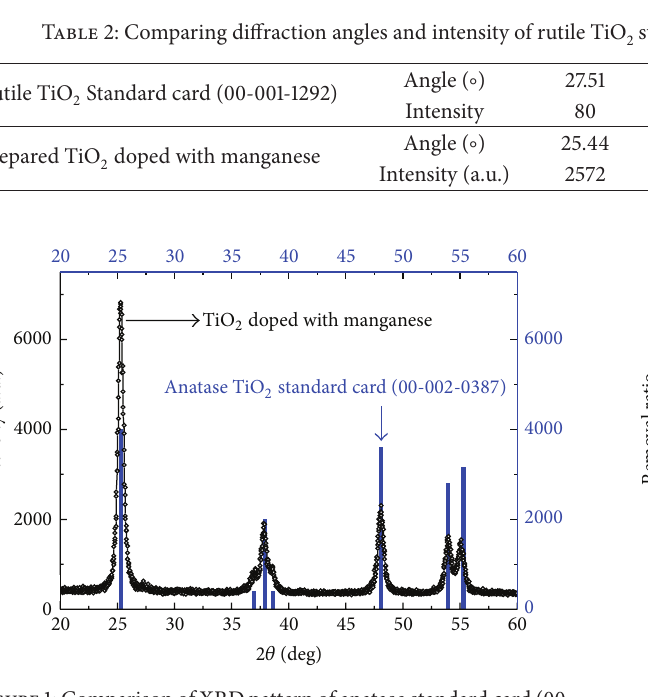
doped with manganese. 2